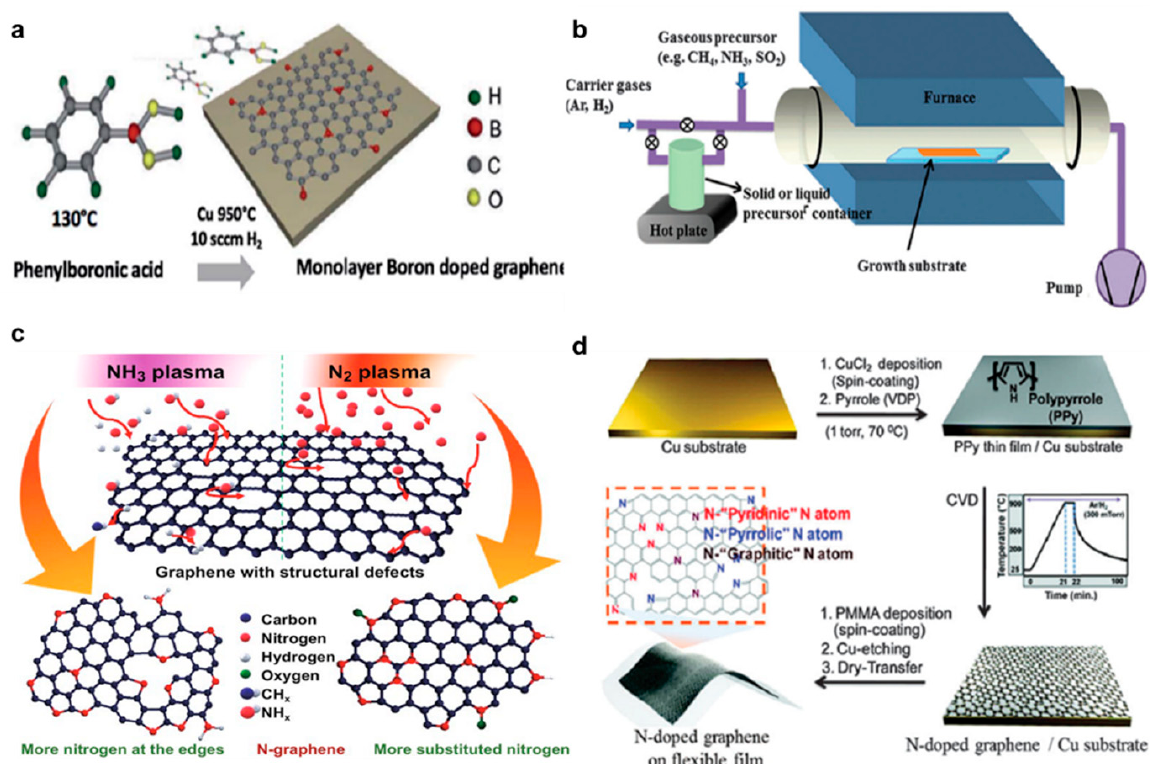
Figure 1. ( a ) Schematic illustration of the chemical vapor deposition (CVD) deposition of B-G on Cu foils by using phenylboronic acid (adapted from [23] with permission from Journal of Materials Chemistry A). ( b ) Experimental setup commonly used for CVD graphene doping (adapted from [25] with permission from Chemical Society Reviews). ( c ) Schematic diagram of the possible mechanism of nitrogen incorporation in CNWs by NH 3 and N 2 plasma post-treatment respectively (adapted from [24] with permission from Nano-Micro Letters). ( d ) N-doped graphene derived from polypyrrole [25] (adapted from [25] with permission from Chemical Society Reviews).